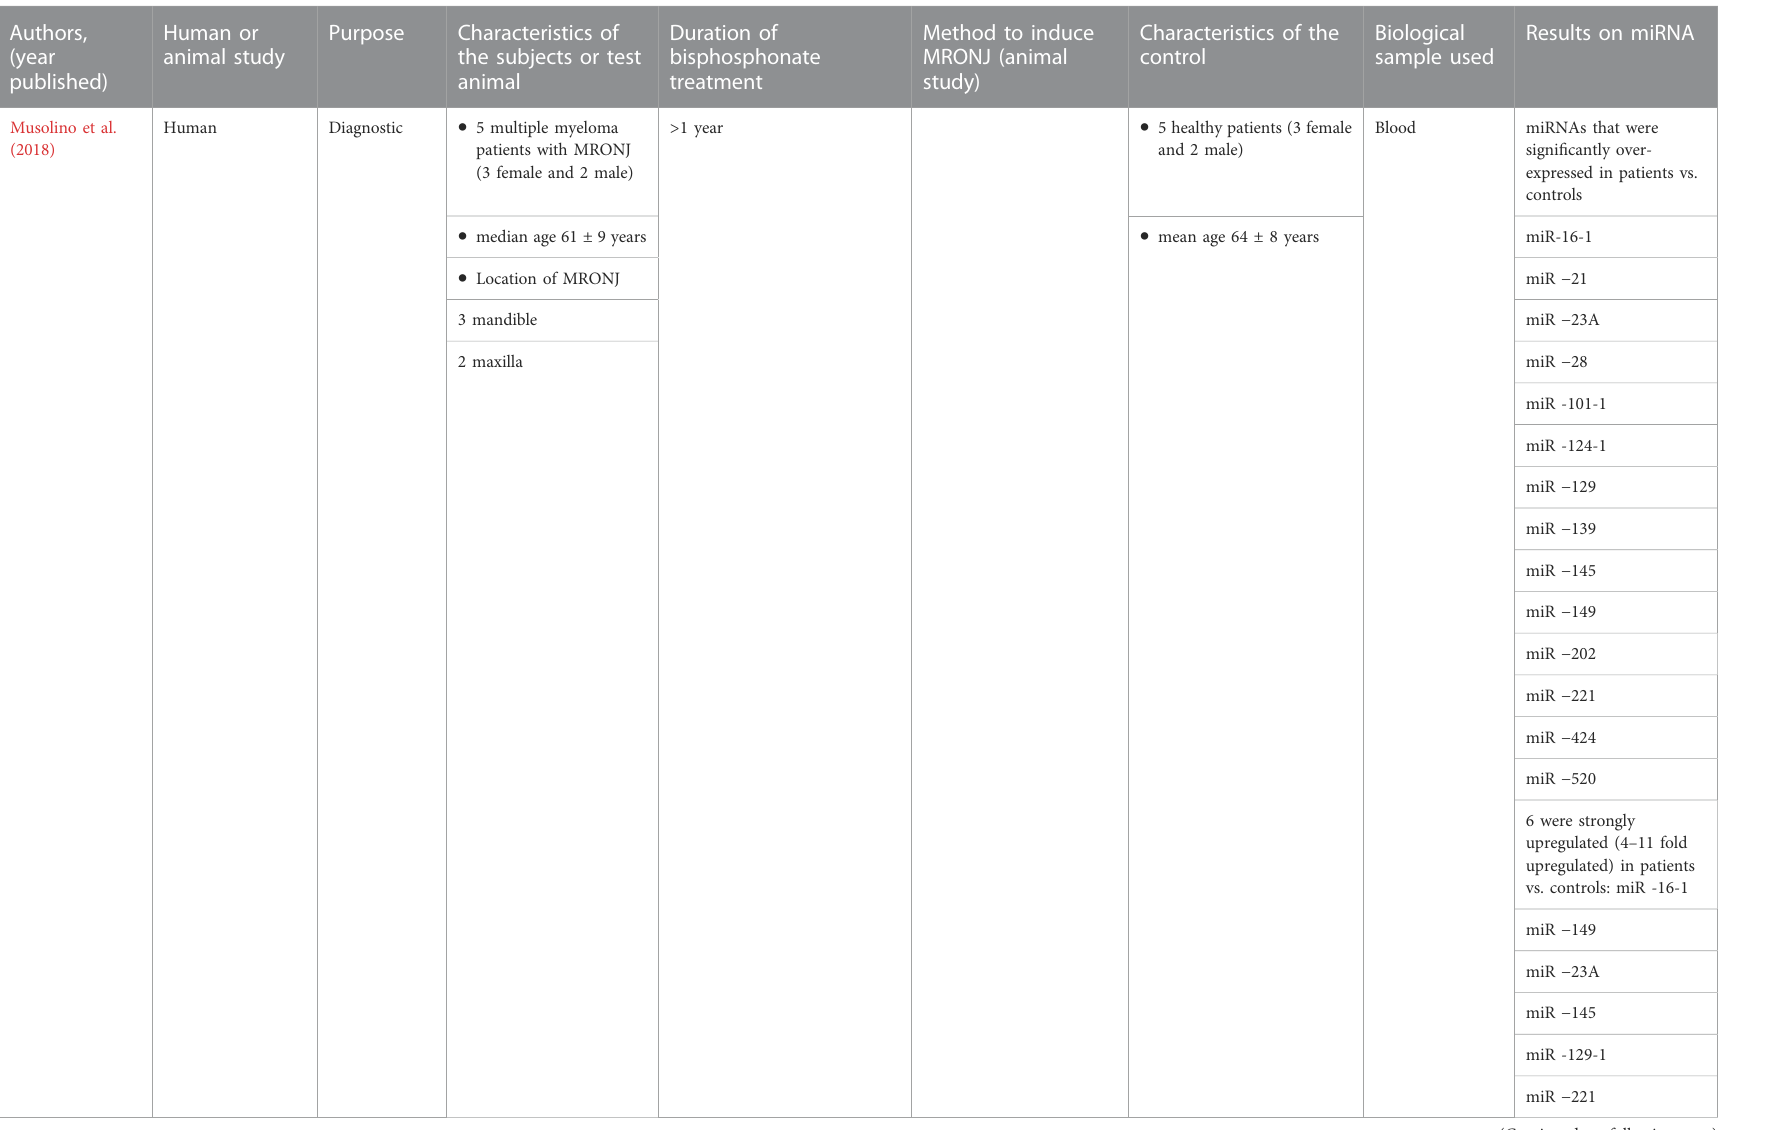
TABLE 2 Summary of the included